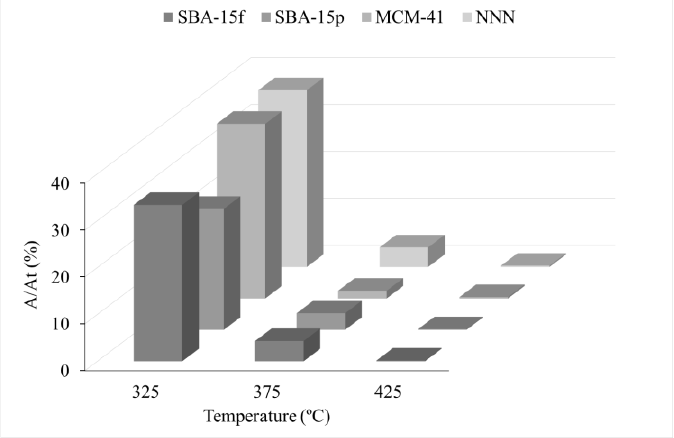
Figure 15. Evolution of NNN for sole NNN and NNN with the three catalysts under air atmosphere. SBA-15p is the catalysts that produces the largest reduction in NNN at 300 ◦ C, where some reduction is observed for the other two catalysts. Nevertheless, this reduction in the NNN decomposition is less significant than under the inert